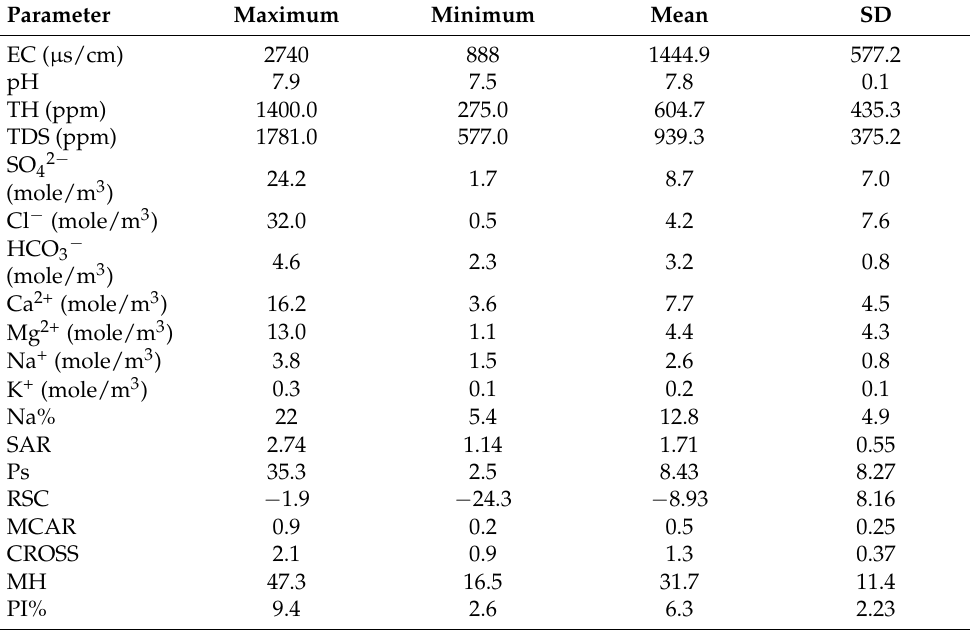
Table 8. Basic statistics of the chemical analysis and field parameters of groundwater